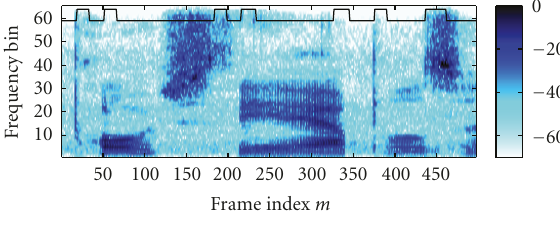
short window set (I) is used, else long window set (II)).